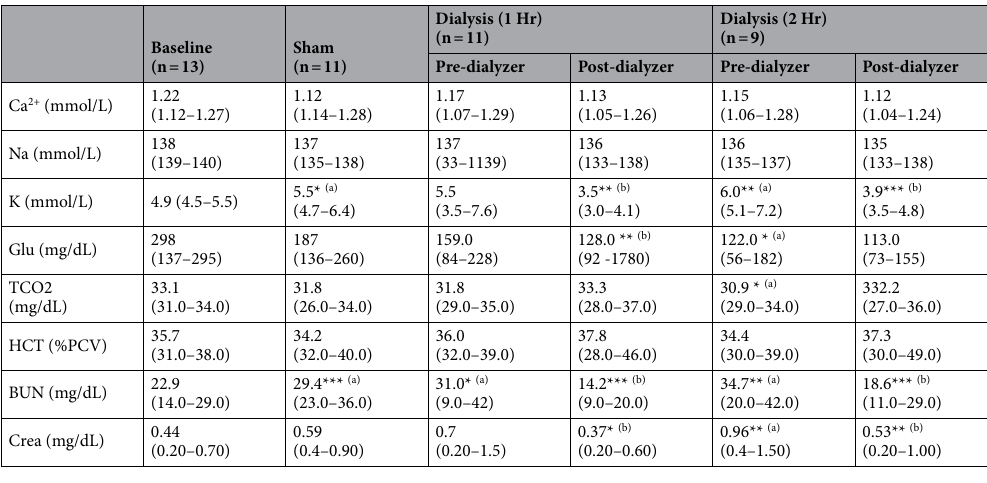
Table 2. Blood analysis (Vetscan Chem8+). Mean (range), (n = number of measurements). One-way Anova (Dunnet correction for multiple comparisons). (*): p < 0.05, (**): p < 0.01), (***): p < 0.001, (****): p < 0.0001. (a): compared to baseline sample, (b) compared to pre-dialyzer